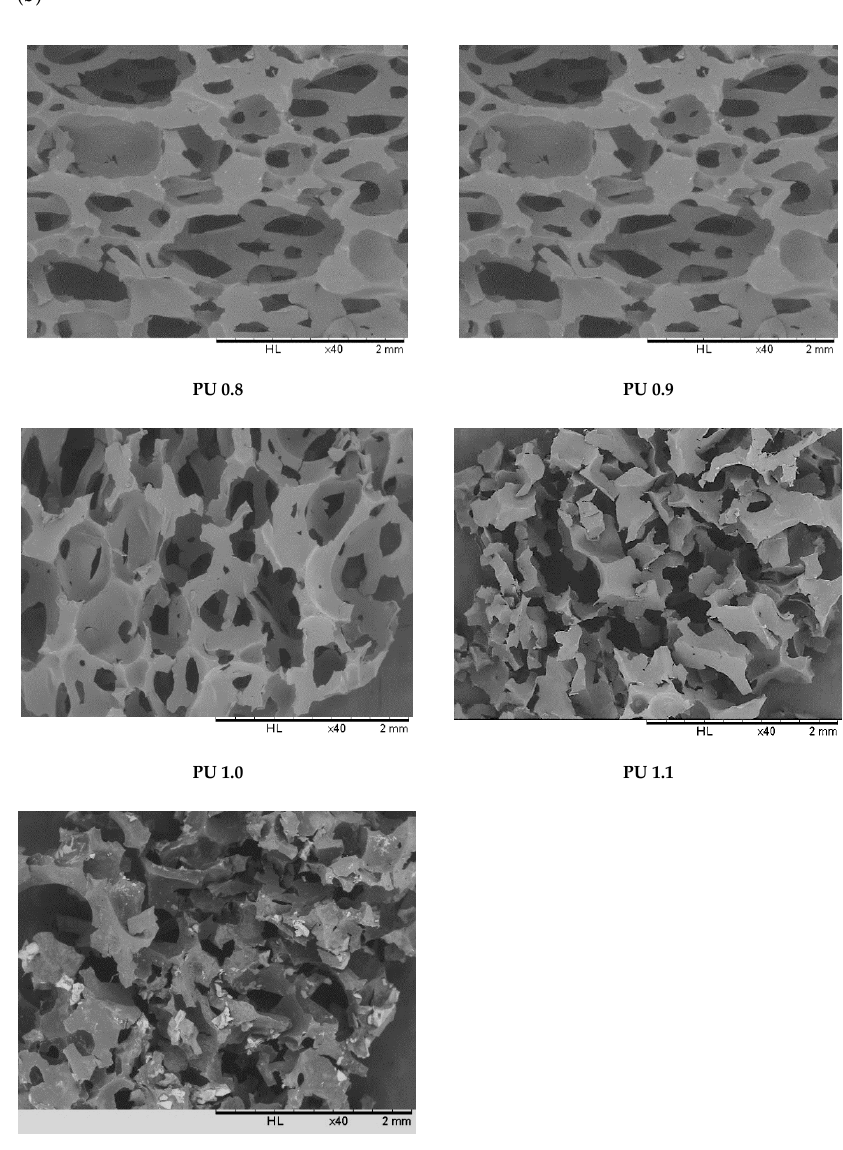
Figure 10. Morphology of polyurethanes after 4 weeks of enzymatic degradation study ( a ) physical appearance ( b ) SEM images (40× magnification) PU 0.8, PU 0.9, PU 1.0, PU 1.1, PU 1.2 were prepared by reacting palm oil-based polyester polyol with IPDI at an isocyanate index of 0.8, 0.9, 1.0, 1.1 and 1.2, respectively.